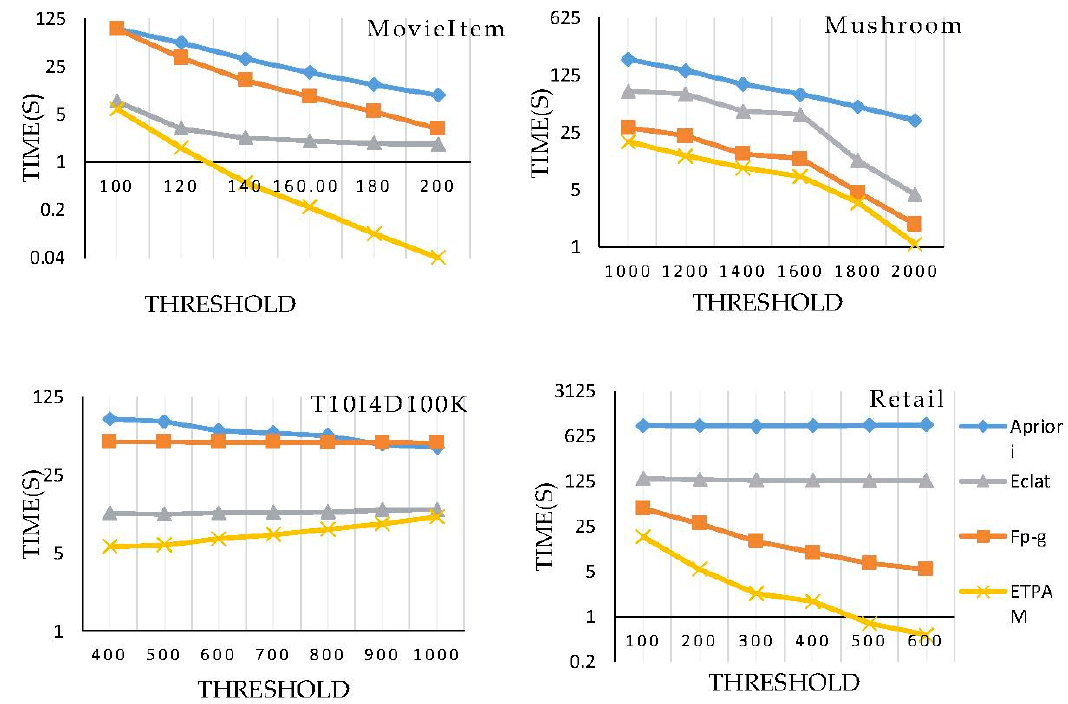
Figure 3. Running times of the four algorithms on the four databases.